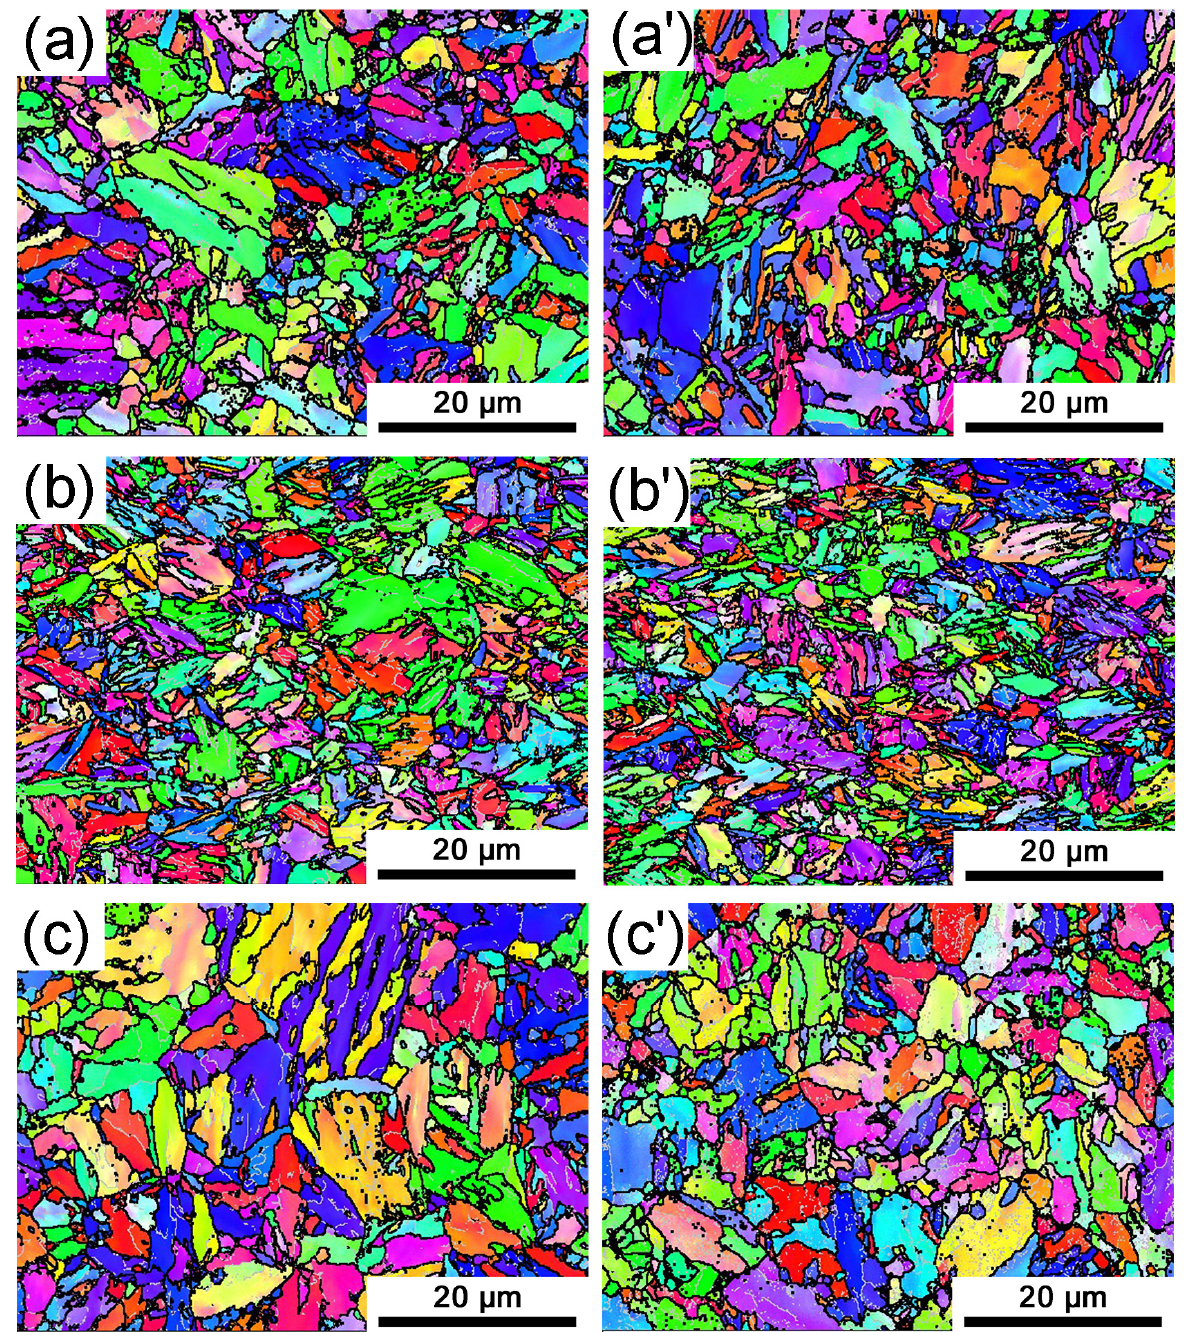
Figure 4. IPF maps of marstenite structure after quenched in the quenching oil of ( a ) traditional process and ( a ′ ) CSP process, the water of ( b ) traditional process and ( b ′ ) CSP process, and the 10 wt.% NaCl solution of ( c ) traditional process and ( c ′ ) CSP process.